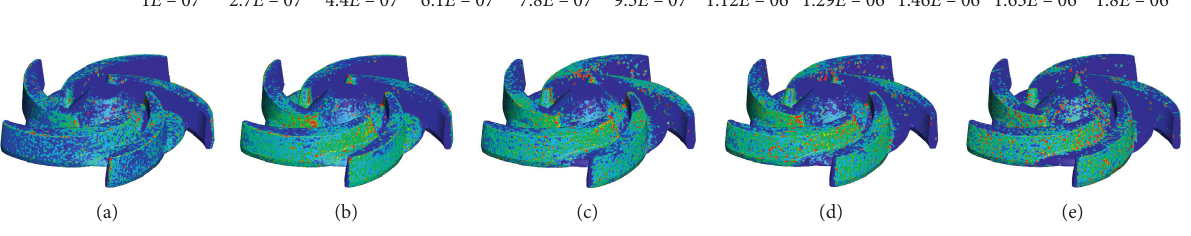
Figure 13: Impeller wear clouds at different particle volume concentrations. (a) C � 10%, (b) C � 15%, (c) C � 20%, (d) C � 25%, and (e) C � 30%.